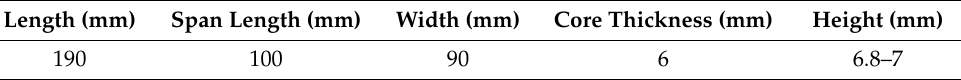
Table 1. Dimensions of the produced parts for the three-point bending tests. Length